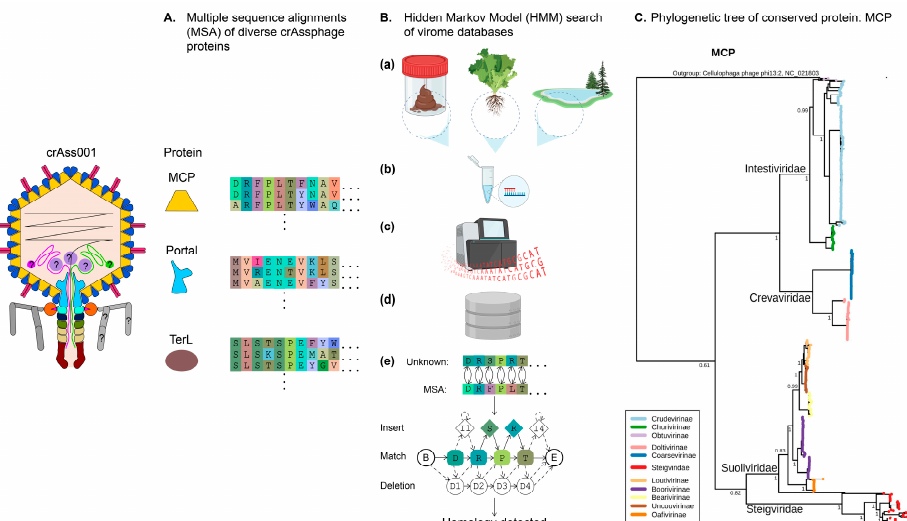
Figure 1. Bioinformatic approaches to discovering and classifying crAss-like phages. ( A ), Multiple sequence alignments (MSA) of the evolutionary conserved phage proteins such as major capsid protein (MCP), portal protein, and terminase large subunit (TerL) contain signatures specific to the order Crassvirales . MSAs are converted to profile HMMs (Hidden Markov Models). ( B ), Discovery and classification of new Crassvirales . Candidate genomes are collected from varied environments such as stool, soil, or aquatic biomes ( a ); shotgun sequencing and assembly of total or VLP-enriched DNA ( b , c ) yields large assembly databases ( d ); translated proteins are compared to MSAs of conserved Crassvirales proteins through sensitive position-specific homology detection algorithms (PSI-BLAST, HMM, and HHM). ( C ), Using MCP as a taxonomic marker protein, a maximum likelihood phylo- genetic tree can be constructed to infer relatedness between families (main fi rst-order branch names) of crAss-like phages [48].